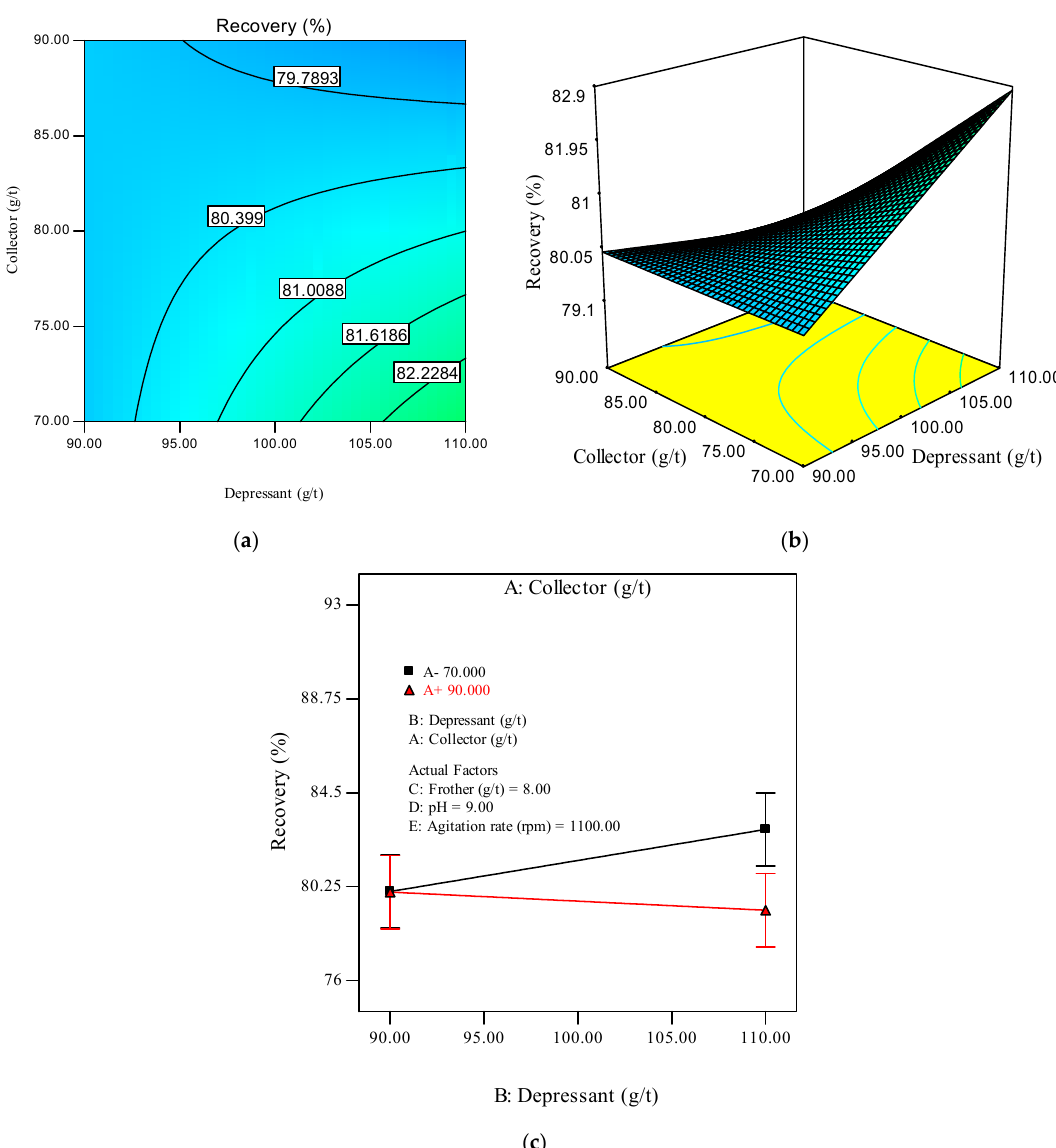
Figure 2. ( a ) Contour and ( b ) 3D response surface plots showing the combined effect of collector and depressant and ( c ) their interaction effect on the copper recovery.